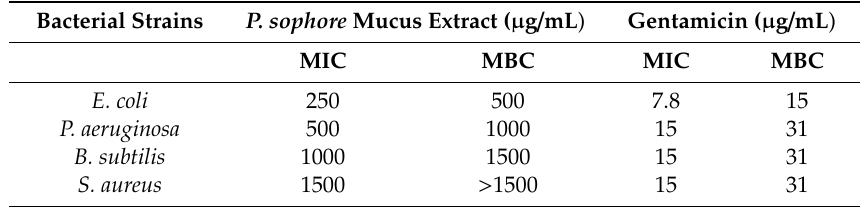
Table 1. Antibacterial activity of P. sophore mucus extract. Bacterial